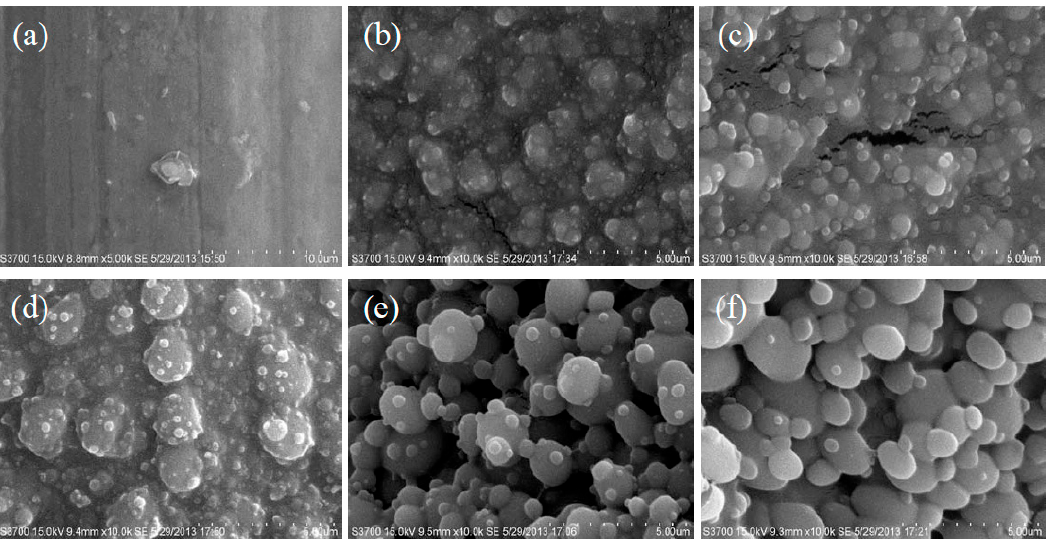
Figure 5. SEM images of hybrid-coated mesh films after secondary coating. The SiO 2 content is ( a ) 33%, ( b ) 40%, ( c ) 50%, ( d ) 60%, ( e ) 66% and ( f ) 75%.